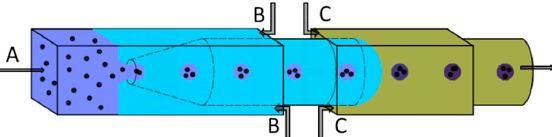
Figure 2. Schematic illustration of a capillary-based single emulsion device for fabricating monodisperse PNIPAm microgels. This device was used by Chu et al. [46]. A containing